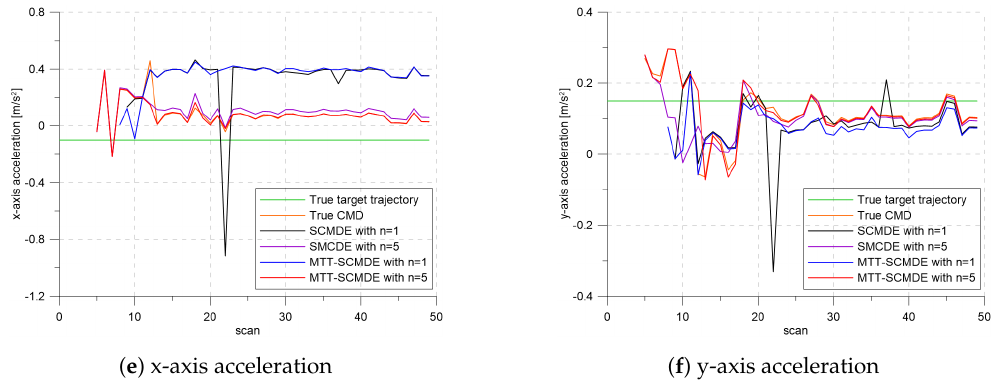
Figure 7. The true states and the estimated states of Target 1 over time.